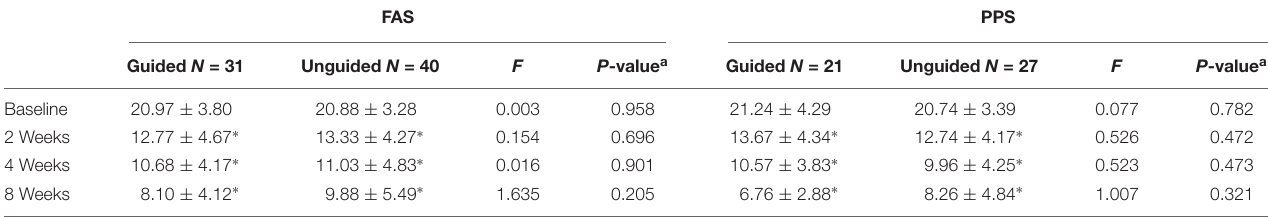
TABLE 5 | Comparison of the response rates and remission rates between the Guided and Unguided group at the end of 8 weeks. FAS